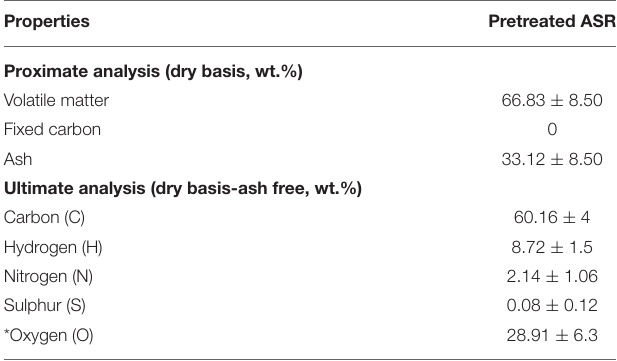
TABLE 1 | Proximate and ultimate analysis of pretreated ASR (Vijayan et al., 2021).